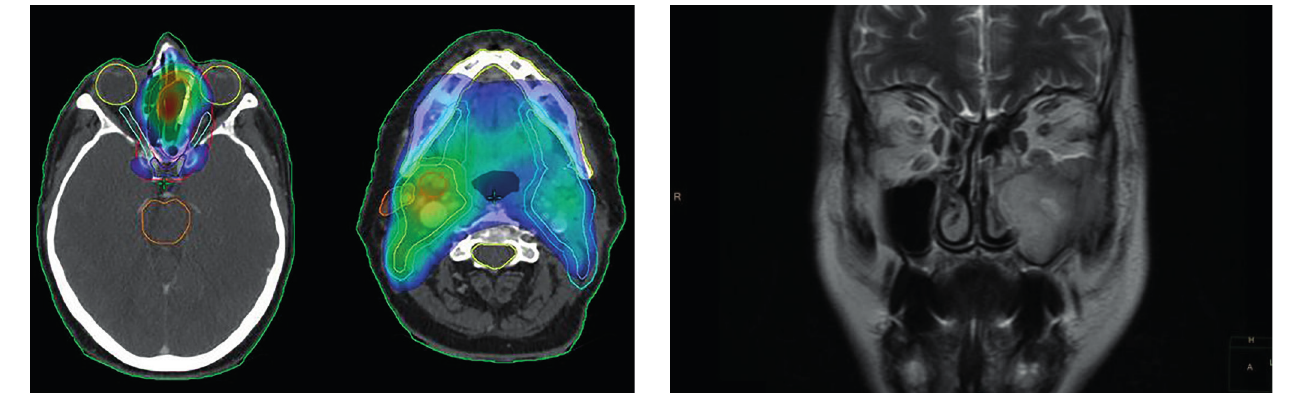
Figure 4. Radiotherapy treatment. Figure 5. MR-T2 .Tumour